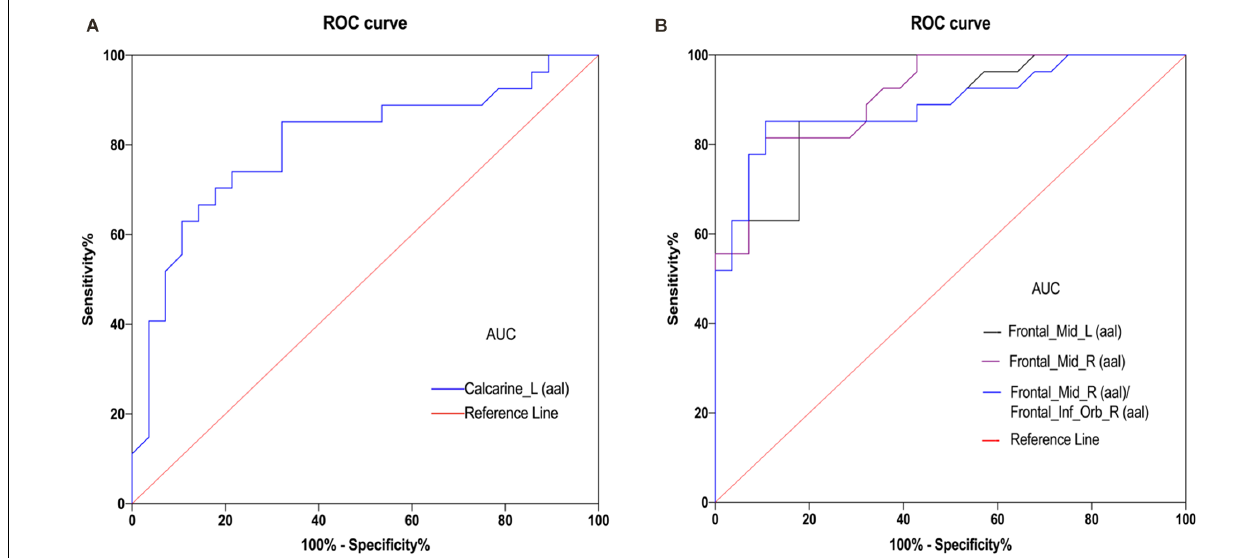
FIGURE 3 | ROC curve analysis of the mean ALFF values for altered brain regions. (A) The area under the ROC curve was 0.8022 ( P < 0.0001; 95% confidence interval (CI) = 0.681–0.924) for Calcarine_L (aal). (B) The area under the ROC curve was 0.8763 ( P < 0.0001; 95% CI = 0.786–0.966) for Frontal_Mid_L (aal); Frontal_Mid_R (aal) 0.9134 ( P < 0.0001; 95% CI = 0. 842–0.985); Frontal_Mid_R (aal)/Frontal_Inf_Orb_R (aal) 0.8909 ( P < 0.001; 95% CI = 0. 802–0.980). Abbreviations: fALFF, fractional amplitude of low-frequency fluctuation; AUC, area under the curve; ROC, receiver operating characteristic; L, left; R, right;